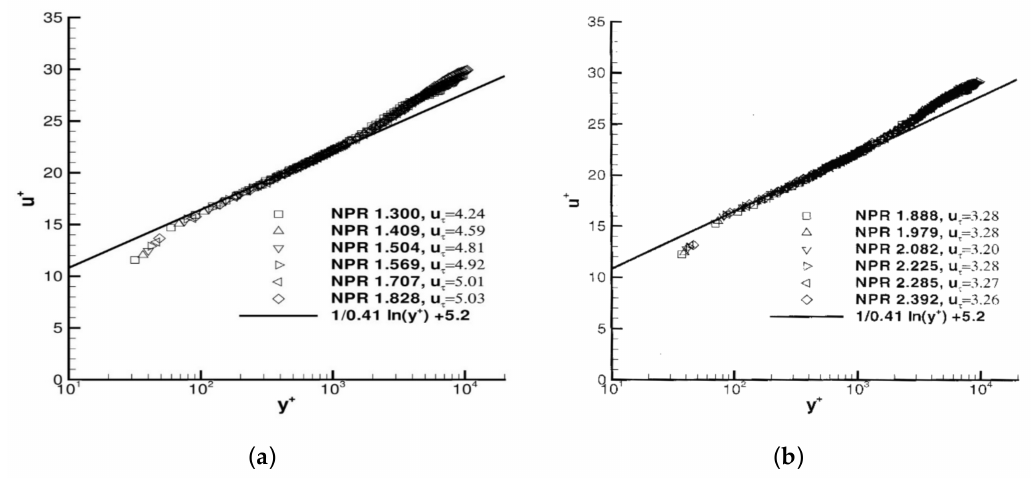
Figure 7. Nozzle inlet mean velocity profile in log-law format. ( a ) Subsonic, LU60; ( b ) supersonic,